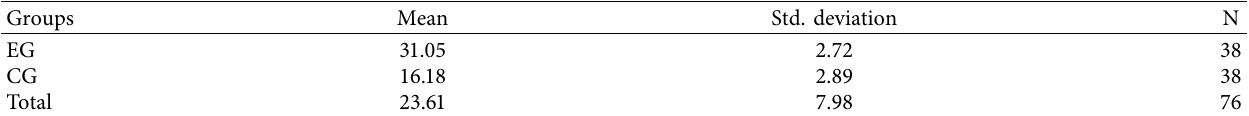
Table 4: Descriptive statistics for the posttest.